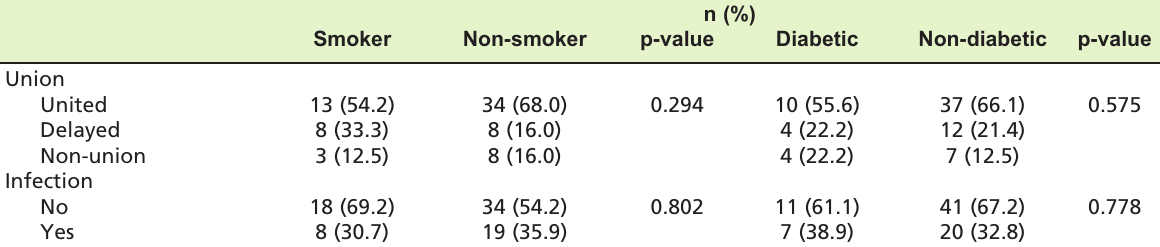
Union complication and infections stratified to smoker vs non-smoker and diabetic vs non-diabetic (N=91) Table V: